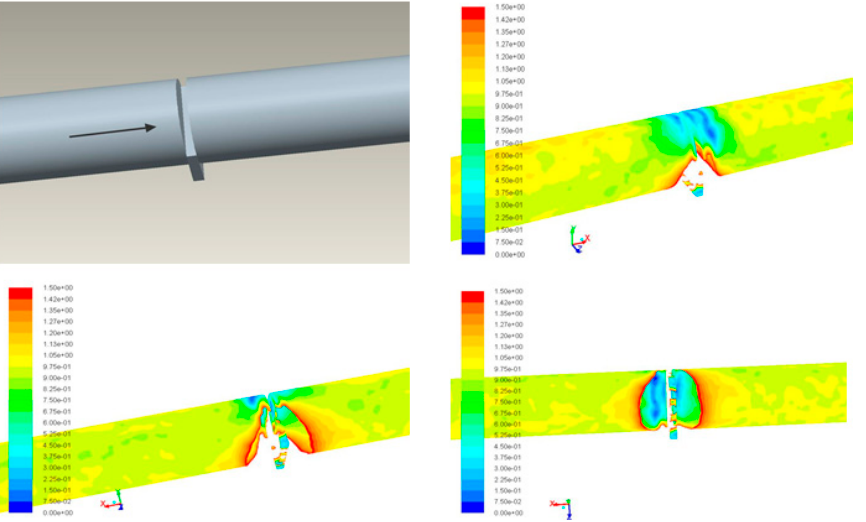
Figure 25. Legend in the